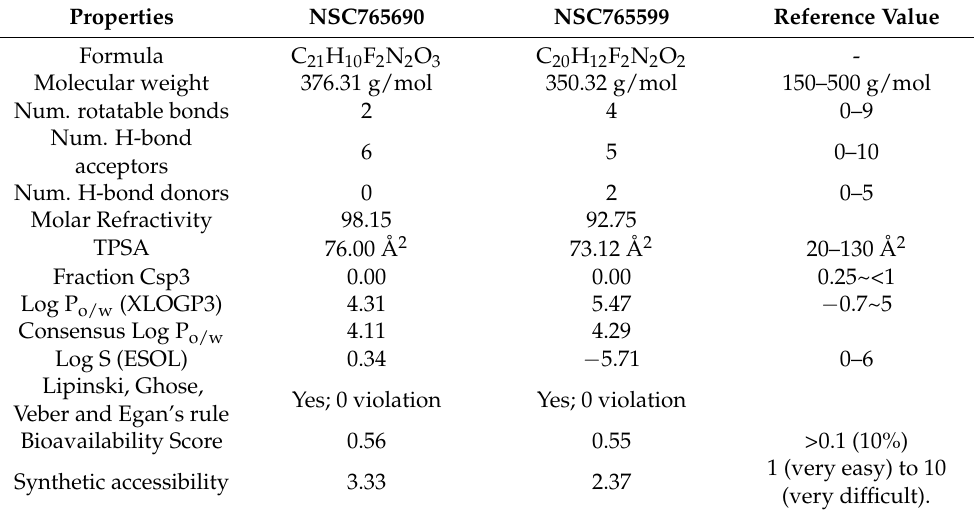
Figure 7. Docking profiles of palbociclib with CDK2, CDK4, and CDK6. Two dimensional (2D) representations of ligand– receptor interactions occurring between palbociclib and the target receptors (CDK2/4/6). The deep-green color indicates the strongest ligand–receptor interaction (due to conventional hydrogen bonds) of the best docking pose. Table 7. Drug likeness, ADME and safety/toxicity profile of NSC765690 and